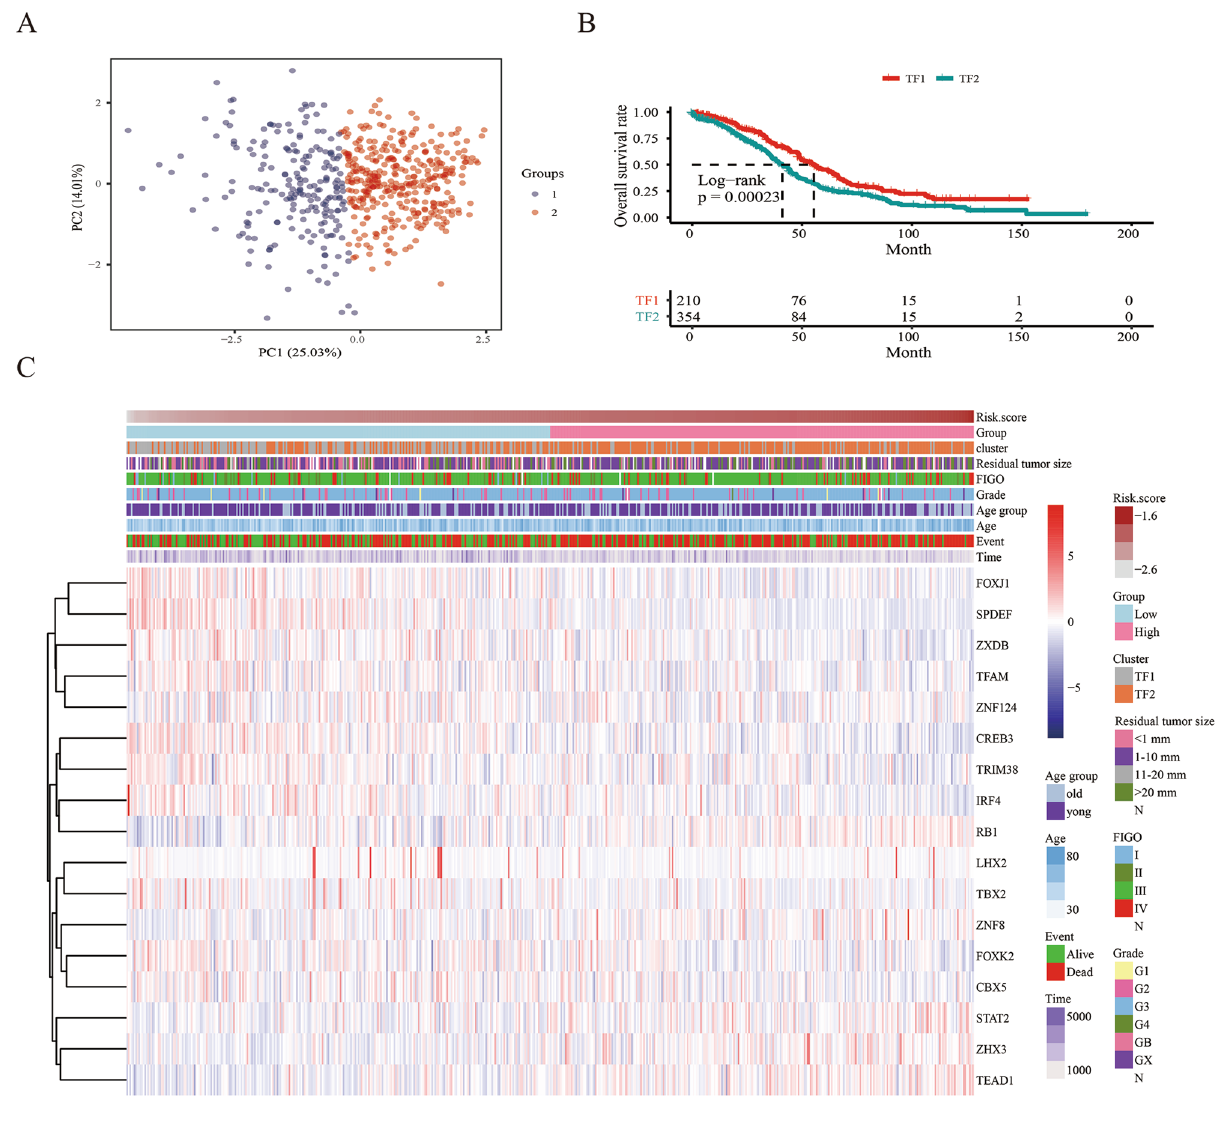
overall survival, age, FIGO sage, Grade and residual resection